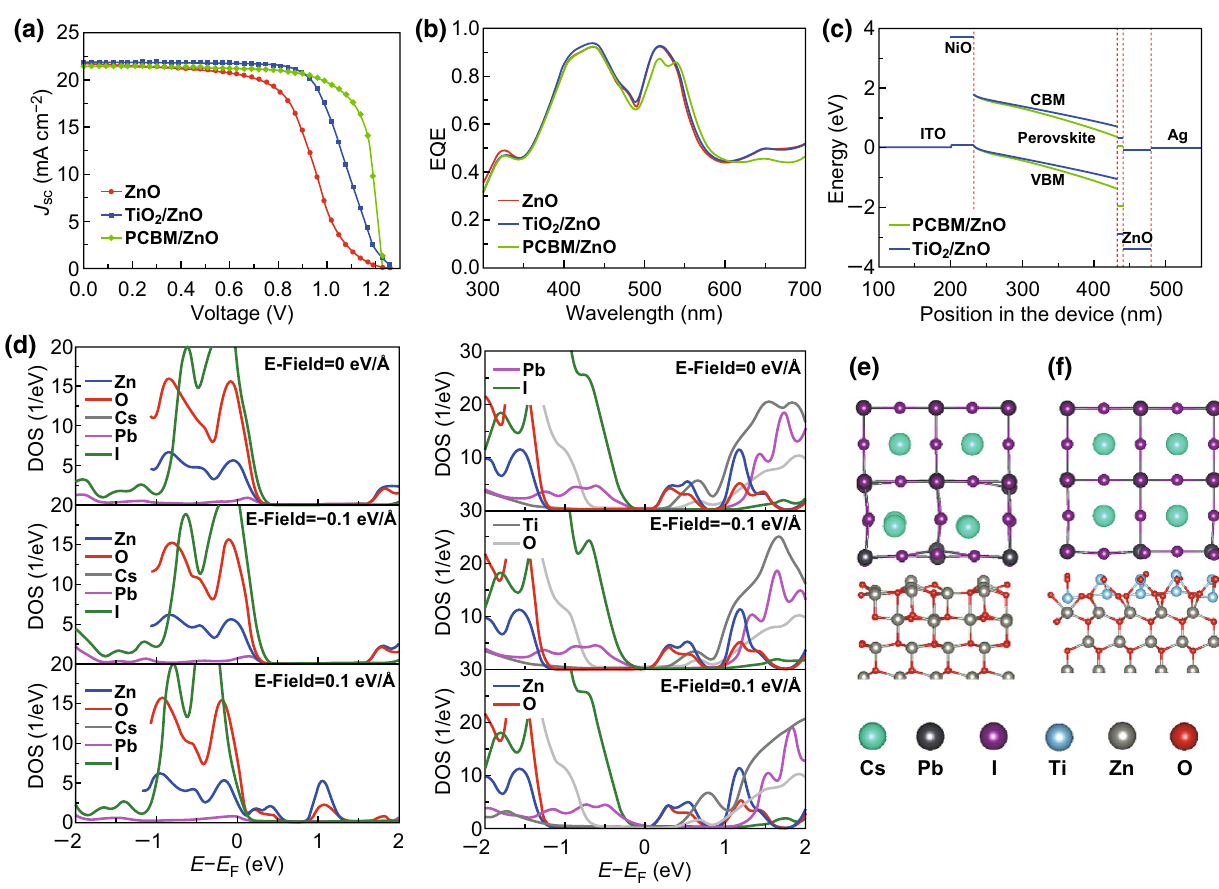
Fig. 7 a J – V characteristics of PSCs with a ZnO single-layer ETL, PCBM/ZnO bilayer ETL, and TiO 2 /ZnO bilayer ETL under a simulated AM 1.5 G illumination of 100 mW cm −2 , in which the doping concentration of the ZnO layer is 10 20 cm −3 . b EQE spectra of devices based on a 200-nm perovskite layer with different ETLs. c Energy band diagrams of the device with a PCBM/ZnO bilayer. d DOS of the CsPbI 3 /ZnO and CsPbI 3 /TiO 2 /ZnO interfaces under different electronic fields. The optimized structures of e CsPbI 3 /ZnO and f CsPbI 3 /TiO 2 /ZnO interfaces are